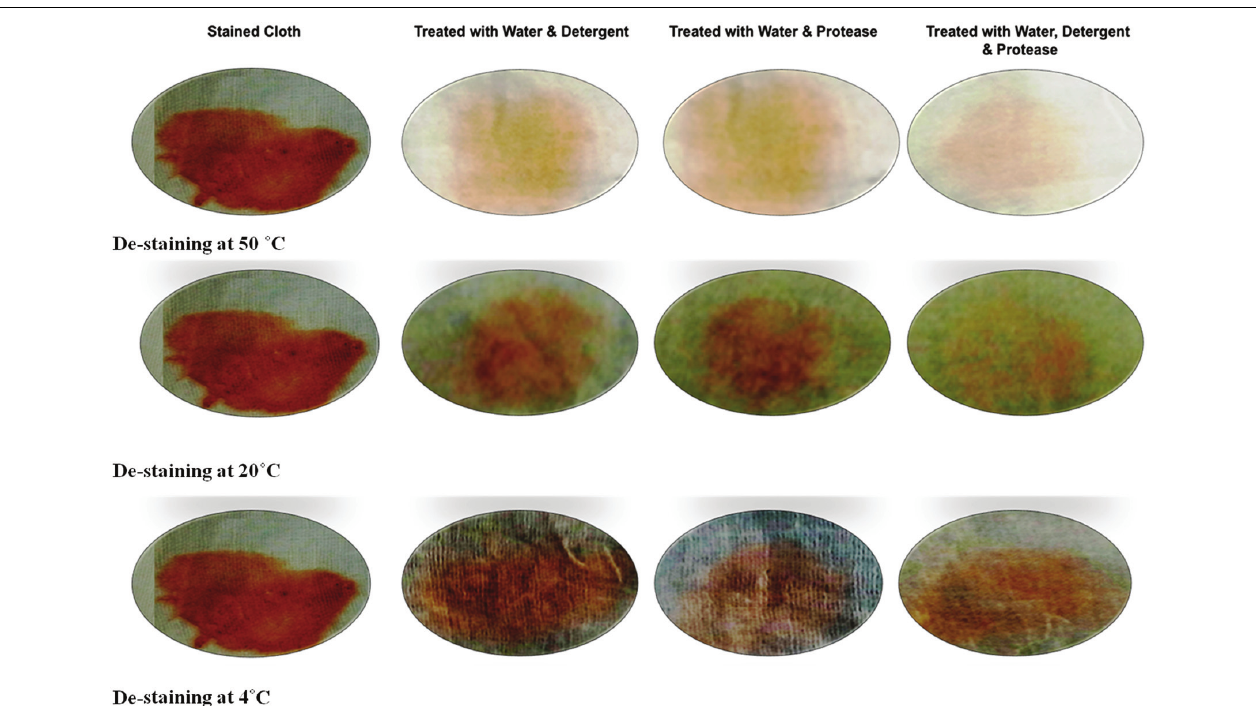
FIGURE 7 | Wash performance analysis of alkaline protease enzyme on different